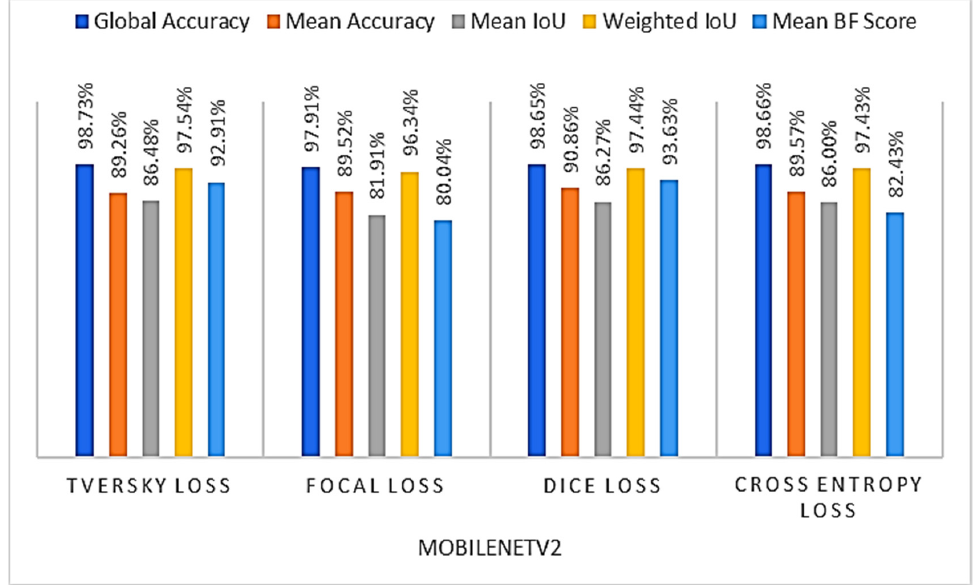
Figure 10. The overall metrics gathered using different loss function with Deeplabv3+ with ResNet-50 as backbone.